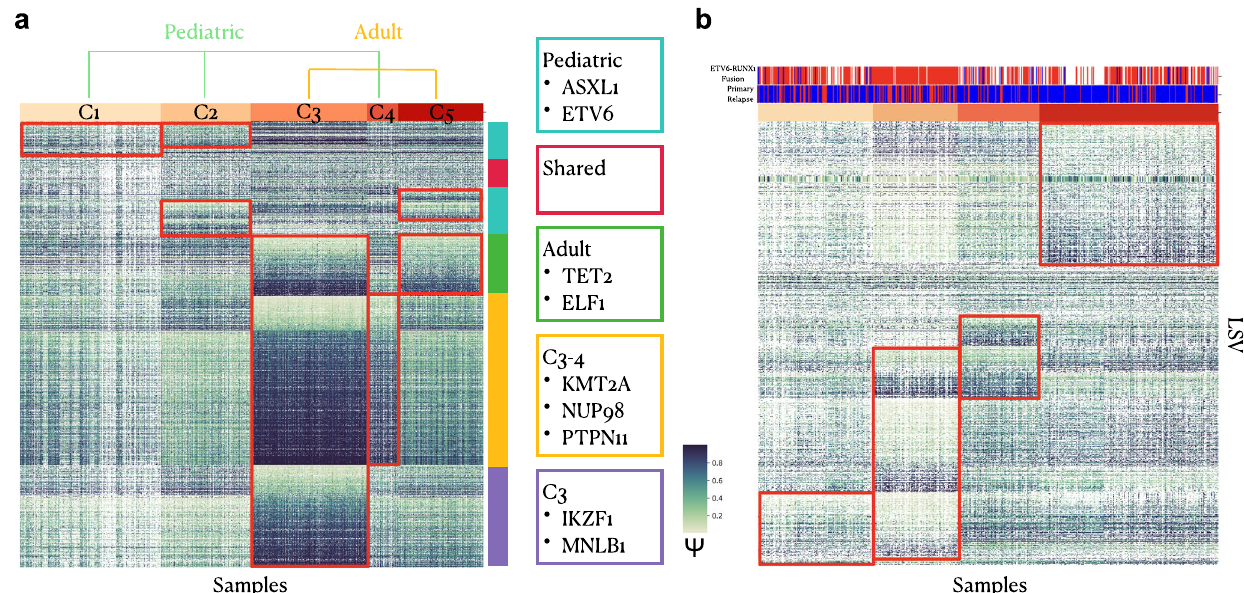
Fig.6|PediatricAMLandB-ALLAnalysis.a Heatmapshowingthetilesdiscovered by CHESSBOARD when applied the joint beatAML and TARGET pediatric AML dataset (samples=1089, LSV=2965). Tiles are outlined in red. Track on the y-axis groupstheLSVsintogroupsde fi nedas:uniquetopediatric(blue),sharedbetween diseases (red), unique to adult (green), unique to one subtype in each disease